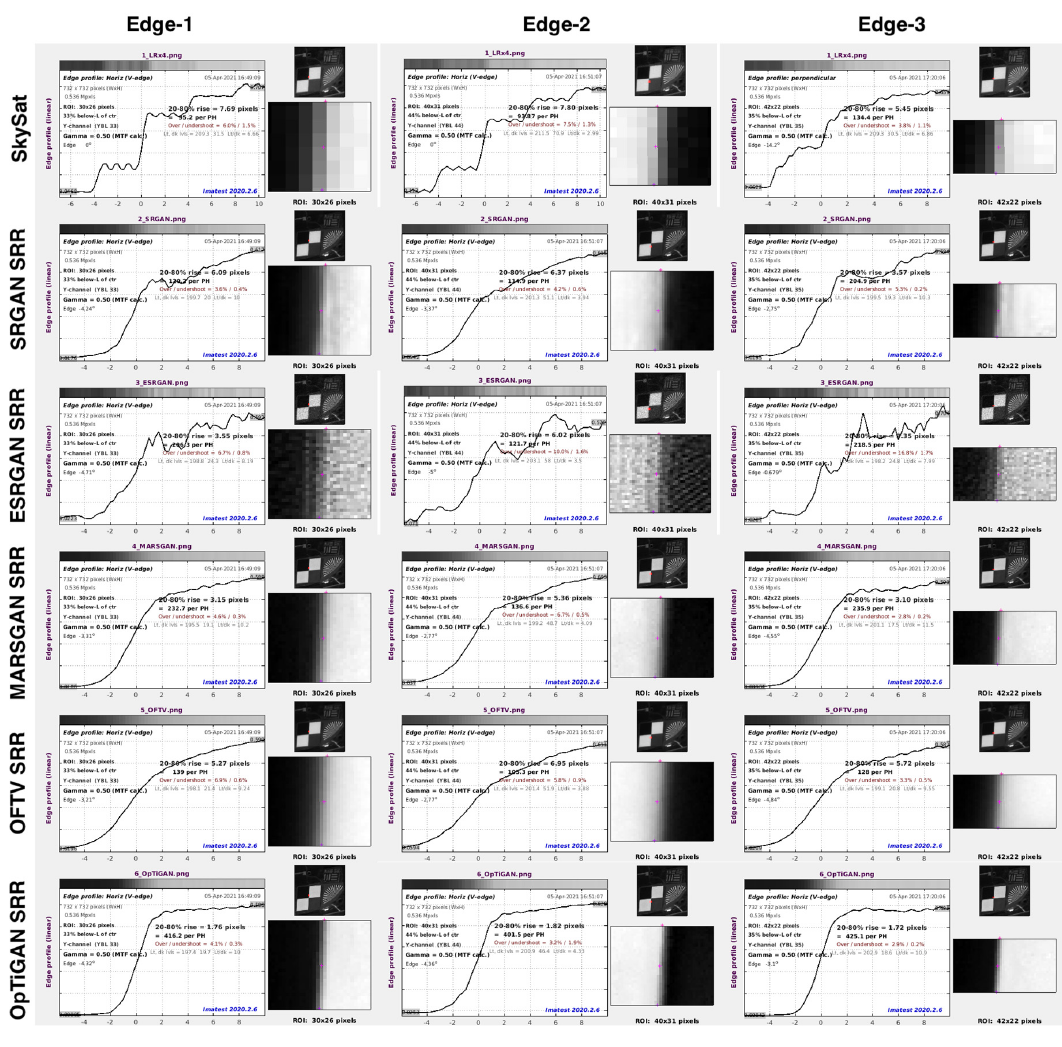
Figure 11. Imatest ® slanted-edge profile measurements for the knife-edge target at the Baotou Geocal site, showing 3 automatically detected edges for each of the input SkySat video frames (upscaled by a factor of 4 for comparison), SRGAN SRR result, ESRGAN SRR result, MARSGAN SRR result, OFTV SRR result and OpTiGAN SRR result. For each slanted edge measurement, there is a plot, showing a profile line crossing the detected edge. Imatest ® measured the total pixel count of a 20–80% profile rise. For texts inside the plots, please refer to the original full-resolution figure in the Supplementary Materials. SkySat image: Skysat L1A imagery provided by Planet Labs, Inc. Table 9. Summary of slanted-edge measurement as shown in Figure 11, for total pixel counts for the 20–80% rise of the edge profile and indicated effective resolution enhancement factor comparing to the input SkySat video frame (upscaled by a factor of 4 for